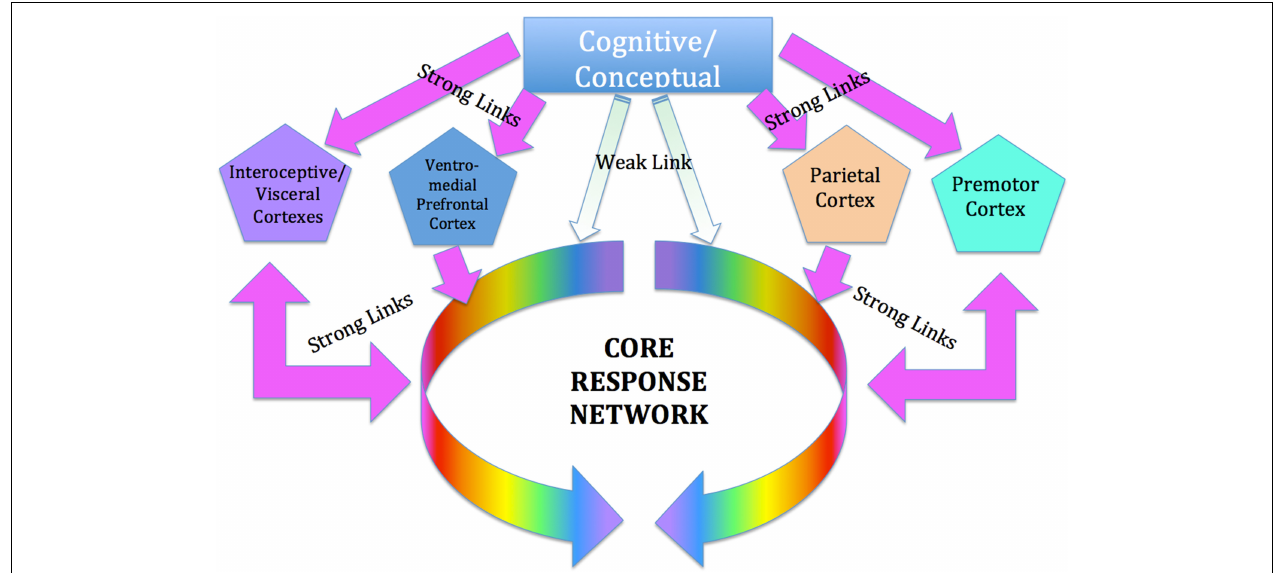
FIGURE 2 | Cortical control of the CRN. We suggest that the influence of conscious conceptual thought processes on the CRN is relatively weak and indirect, whereas the influence of those portions of the cortex mediating interoceptive, proprioceptive and kinesthetic awareness is relatively strong and direct. These areas include the insula and anterior cingulate cortex, which